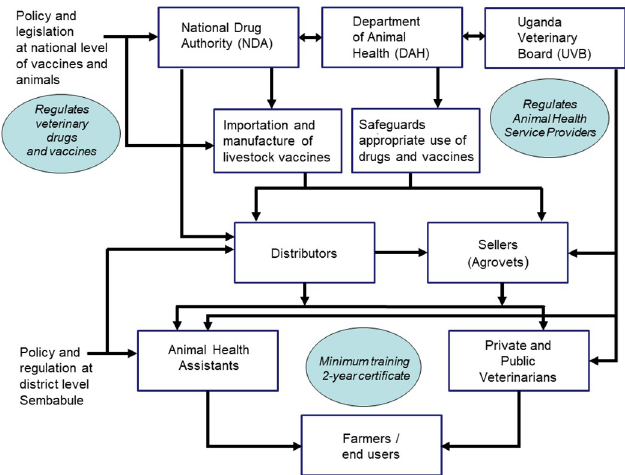
Fig 3. Regulation of veterinary, vaccines, animals, and animal health service providers in